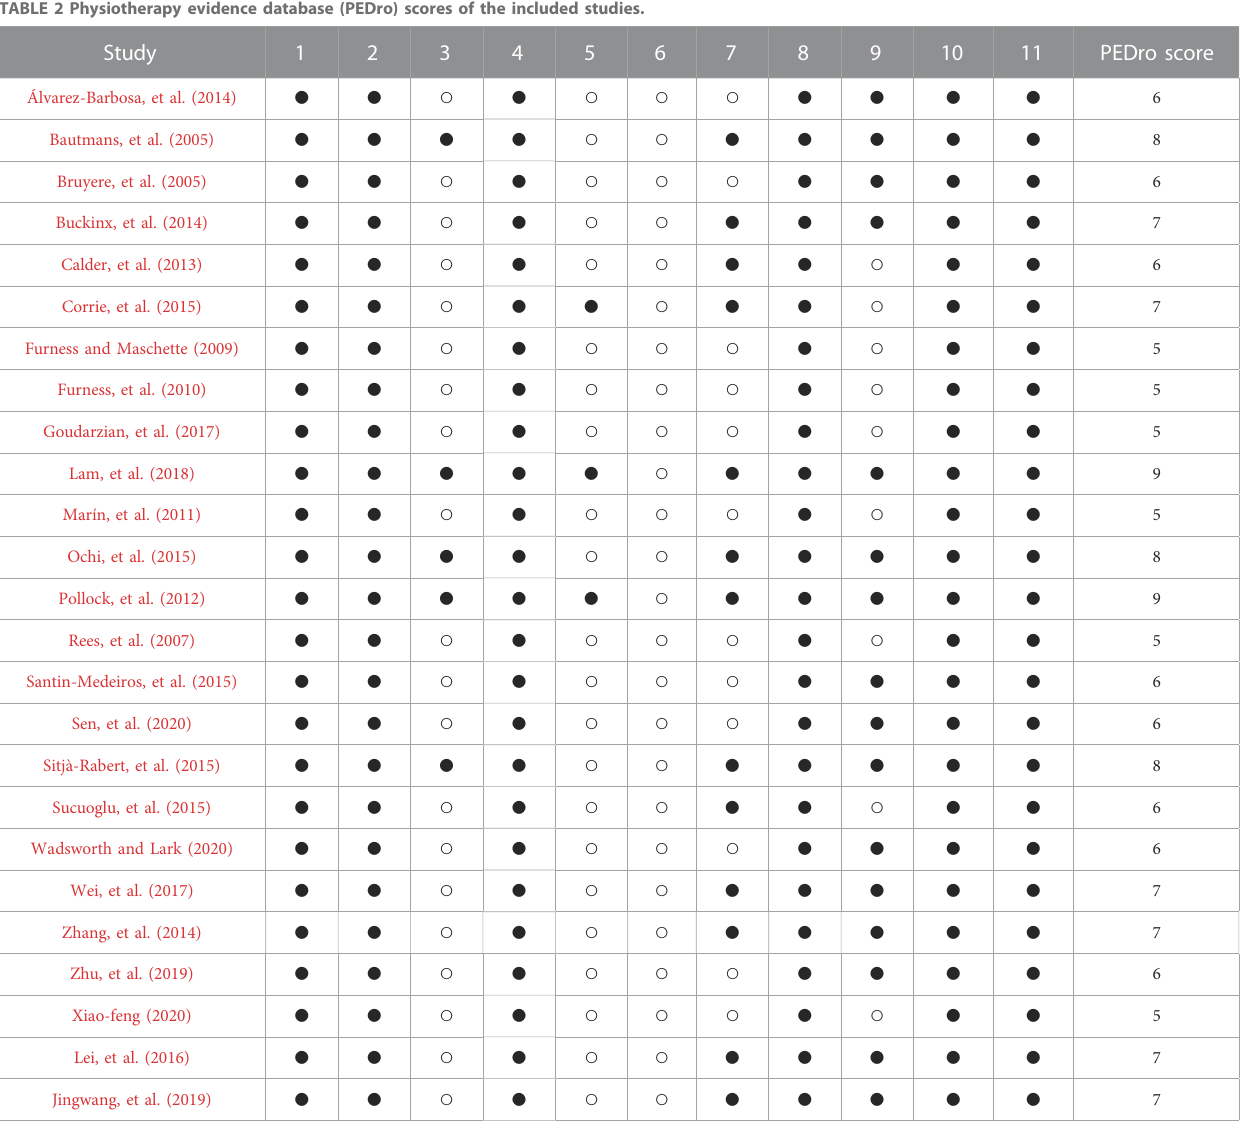
TABLE 2 Physiotherapy evidence database (PEDro) scores of the included